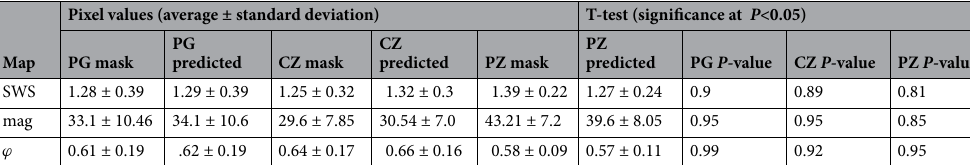
Table 5. Values obtained in PG, CZ and PZ regions of interest using ground truth original and predicted masks. “mask” and “predicted” in the column headers refer to the ground truth and model output, respectively. T-test results between ground truth and predicted masks for PG, CZ and PZ are also reported in the right part of the table (based on segmentation results from UM and input images of mag).